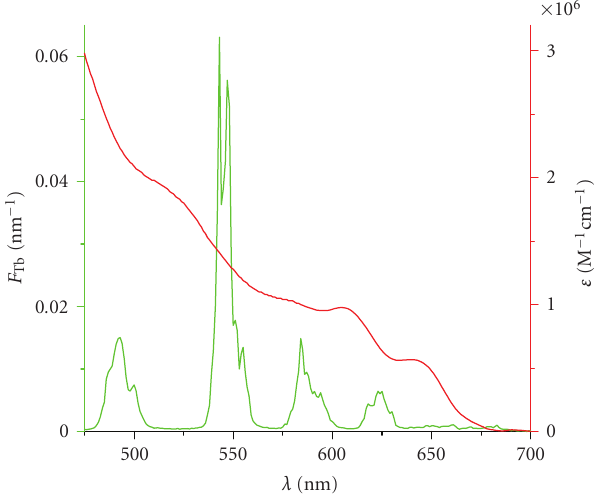
Figure 3: Normalized emission spectrum of Tb L -Strep (green) and extinction coe ffi cient spectrum of Biot-QD (red).